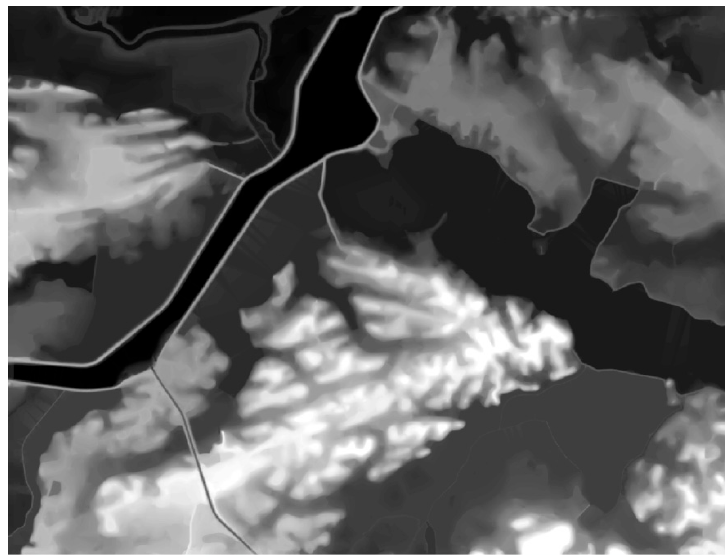
Figure 2. Example of DEM data. The DEM data of each area can be represented as a graph. Each point in the graph corresponds to a sampling point in the area. The gray level of a point represents its elevation value, where the larger the grey level (i.e., brighter), the higher the elevation. The regular rectangular grid is the dataset of elevation values at the plane coordinates position